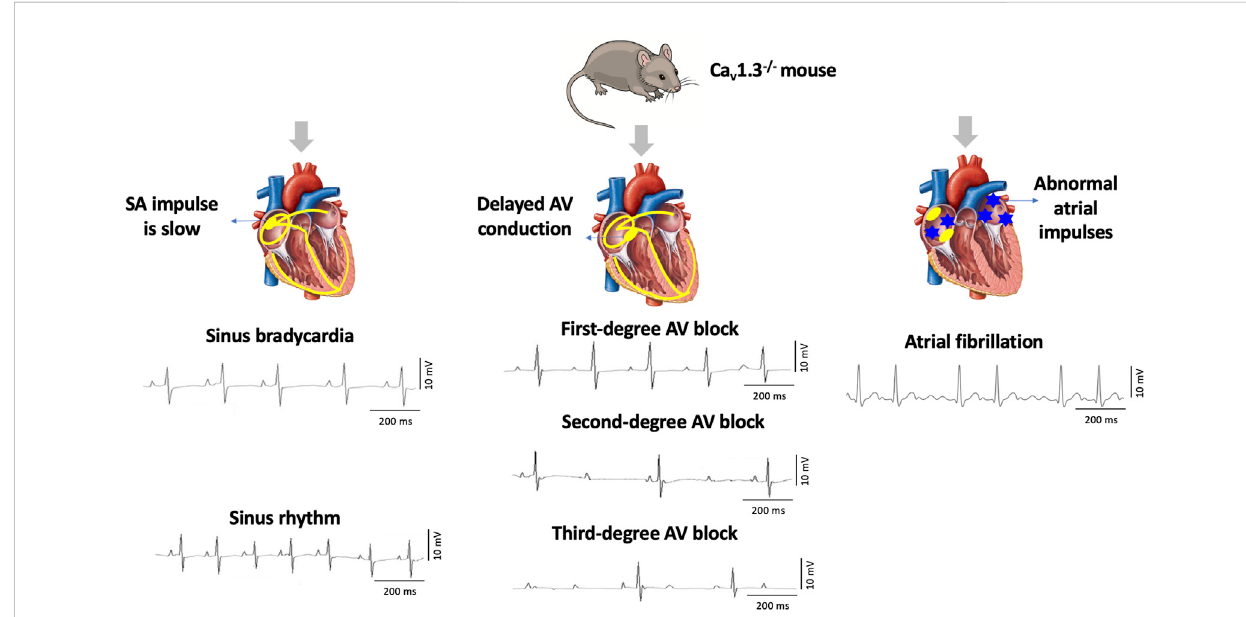
FIGURE 1 Deletion of Ca v 1.3 in mice leads to electrographic abnormalities. The absence of Ca v 1.3 in mice leads to the development of sinoatrial (SA) and atrioventricular (AV) node dysfunction leading to sinus bradycardia and fi rst-degree, second-degree, and third-degree AV block as well as atrial fi brillation